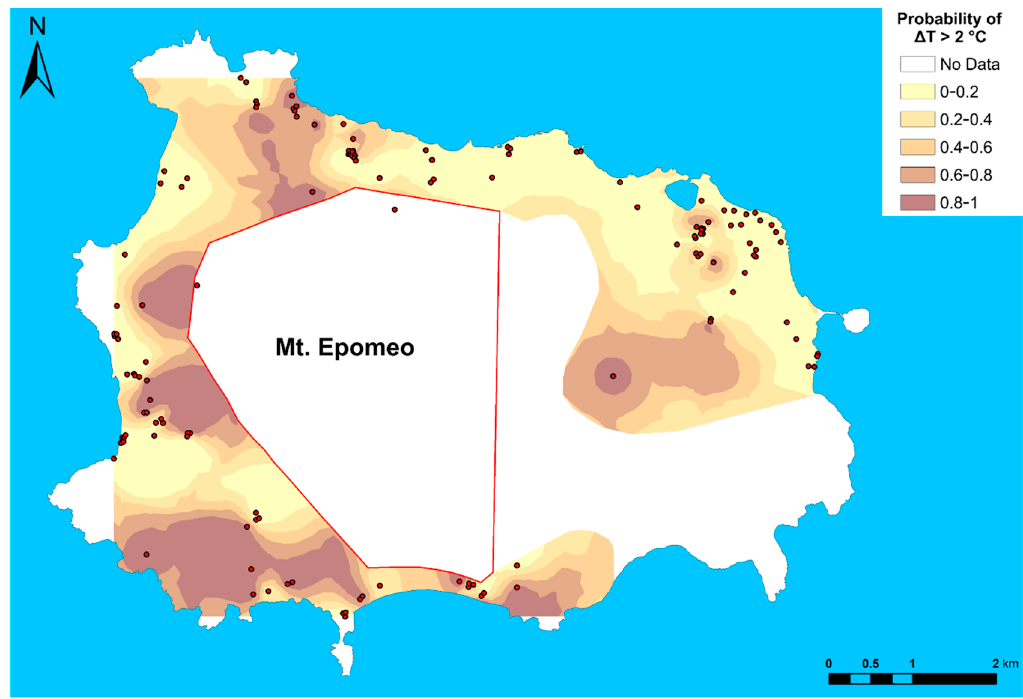
Figure 9. Probability of finding an increase in water temperature ( Δ T) during pumping higher than 2 °C, estimated with Indicator Kriging.